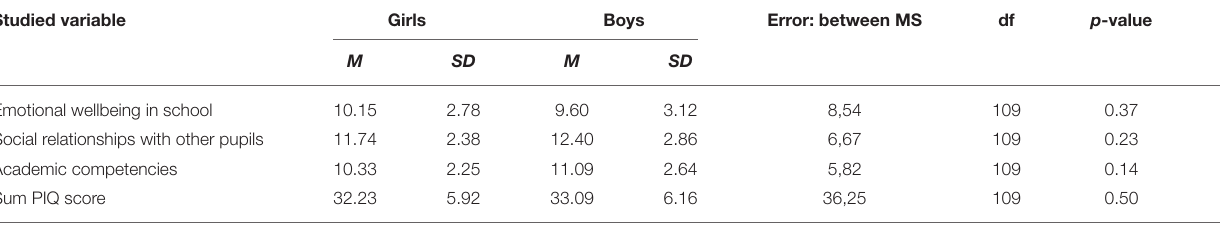
TABLE 1 | Analyses of differences in the PIQ’s results between girls and boys. Studied variable Girls Boys Error: between MS df